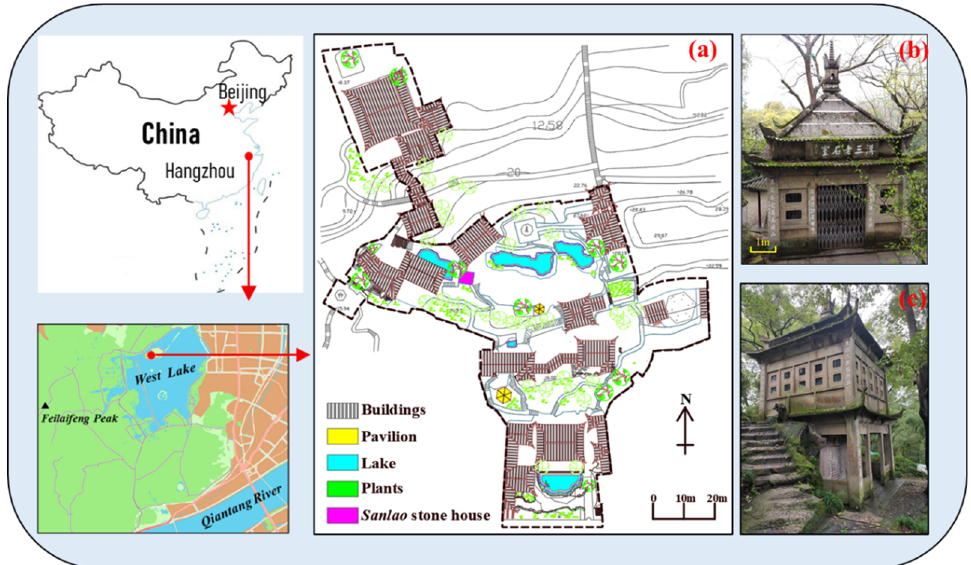
Figure 1. Geographical map of Sanlao stone house. ( a ) Plan of the Xiling Seal Engraver’s Society; ( b ) Front view of Sanlao stone house; ( c ) Side view of Sanlao stone house.